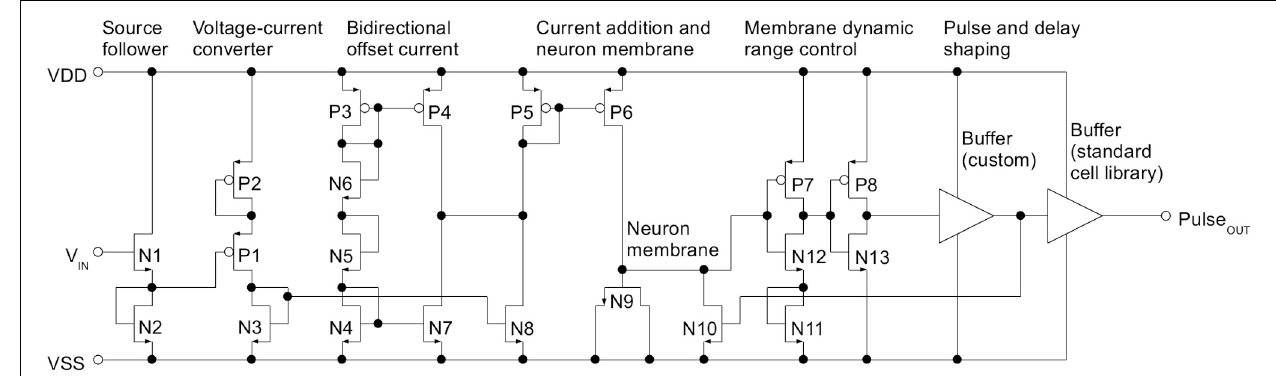
FIGURE 3 | Schematic of the analog neuron, type negative. For clarity, powerdown switching transistors have been